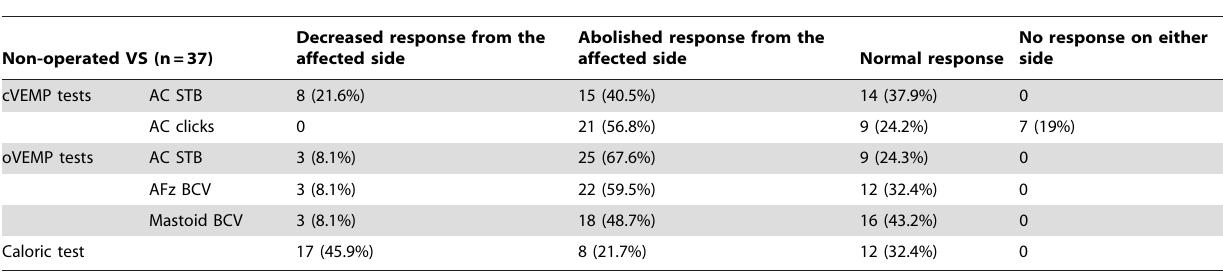
Table 4. Number (%) of responder non-operated VS patients (n=37) exhibiting abnormal decreased response, abnormal abolished response from the affected side (EPr =100%) or normal response to vestibular tests (ACS cVEMPs, AC STB and BCV oVEMPs, and caloric